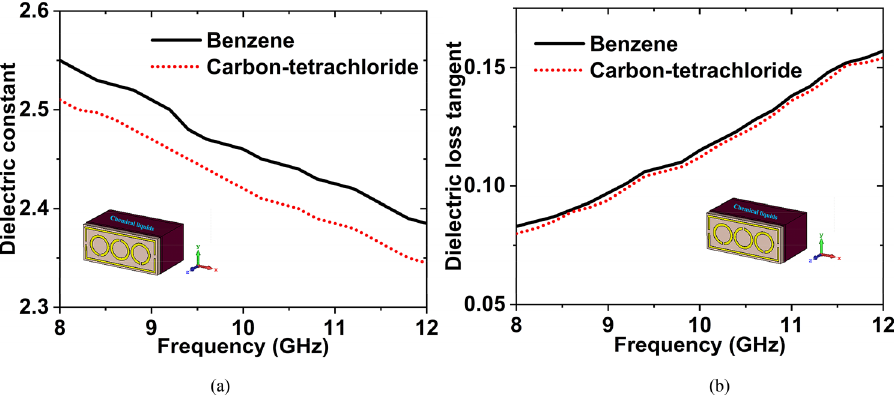
Figure 24. Experimental data of ( a ) DK ( b ) LT for the carbon-tetrachloride & benzene.